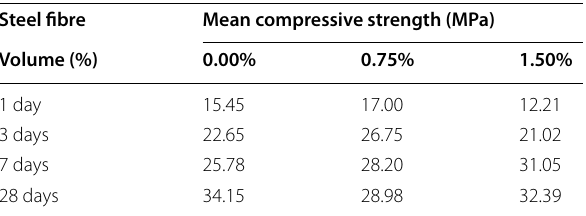
Table 5 Measured moment capacity